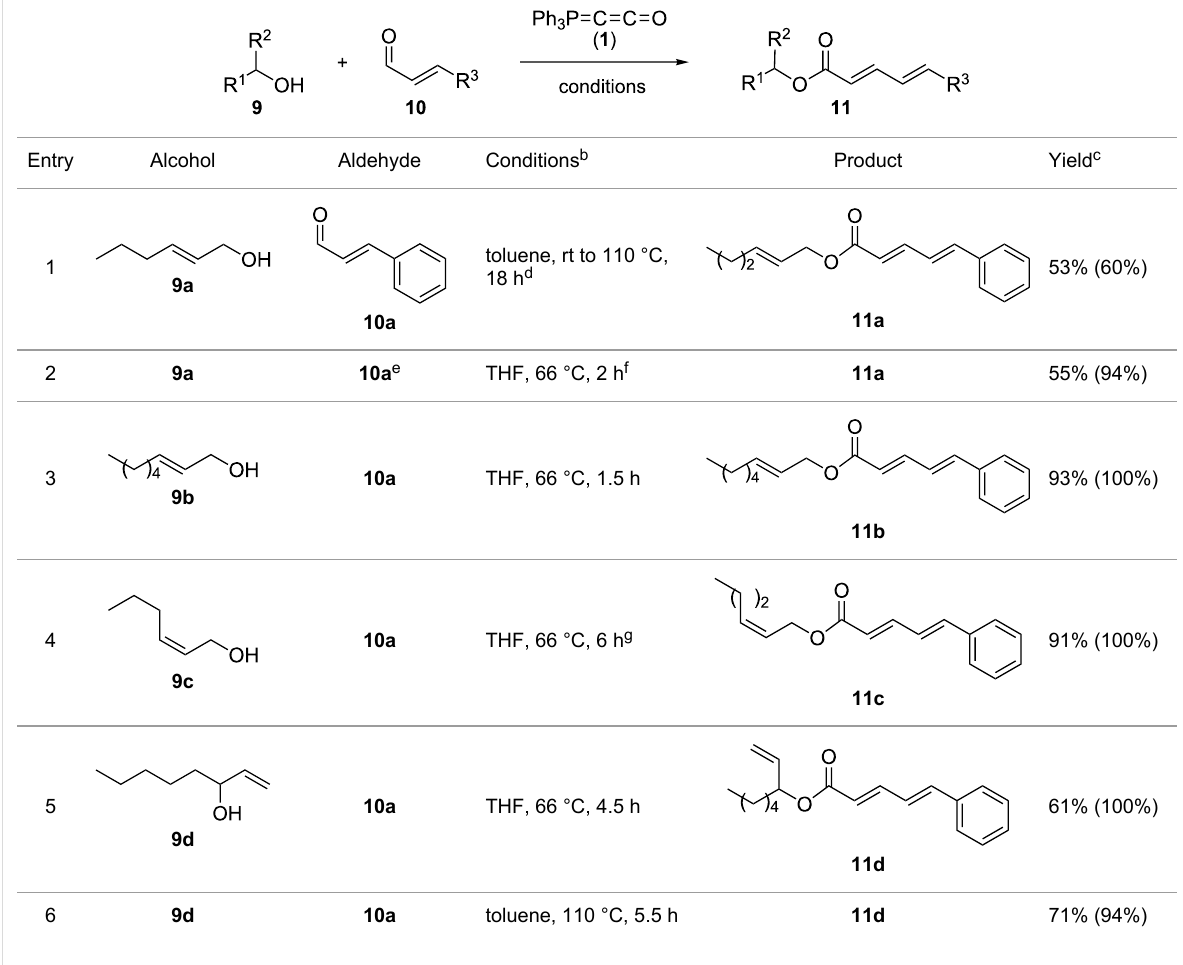
Table 1: Coupling reactions of alcohols 9 and aldehydes 10 with Bestmann ylide ( 1 ) a .